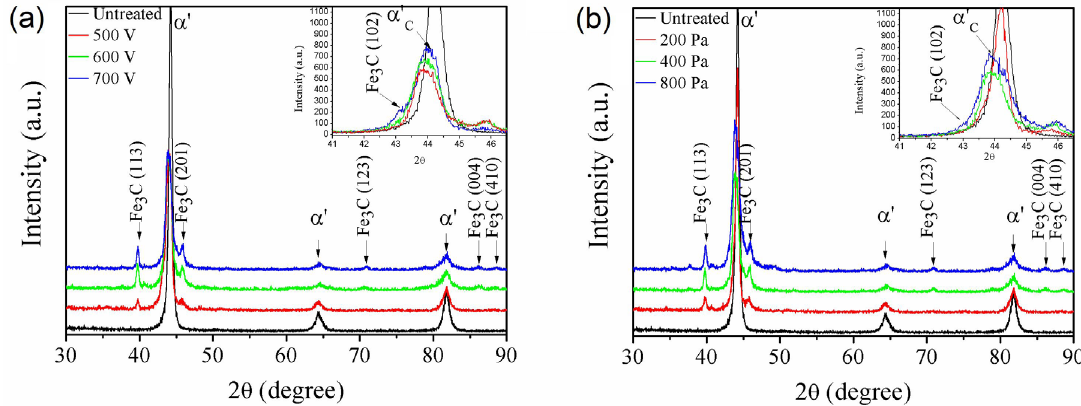
Figure 4. X-ray diffraction patterns of untreated and carburized surfaces obtained for: a) applied pulse voltage; and b) pressure treatment series. Treatments carried out at 450 °C, for 8 h, using 99.5% (80% H